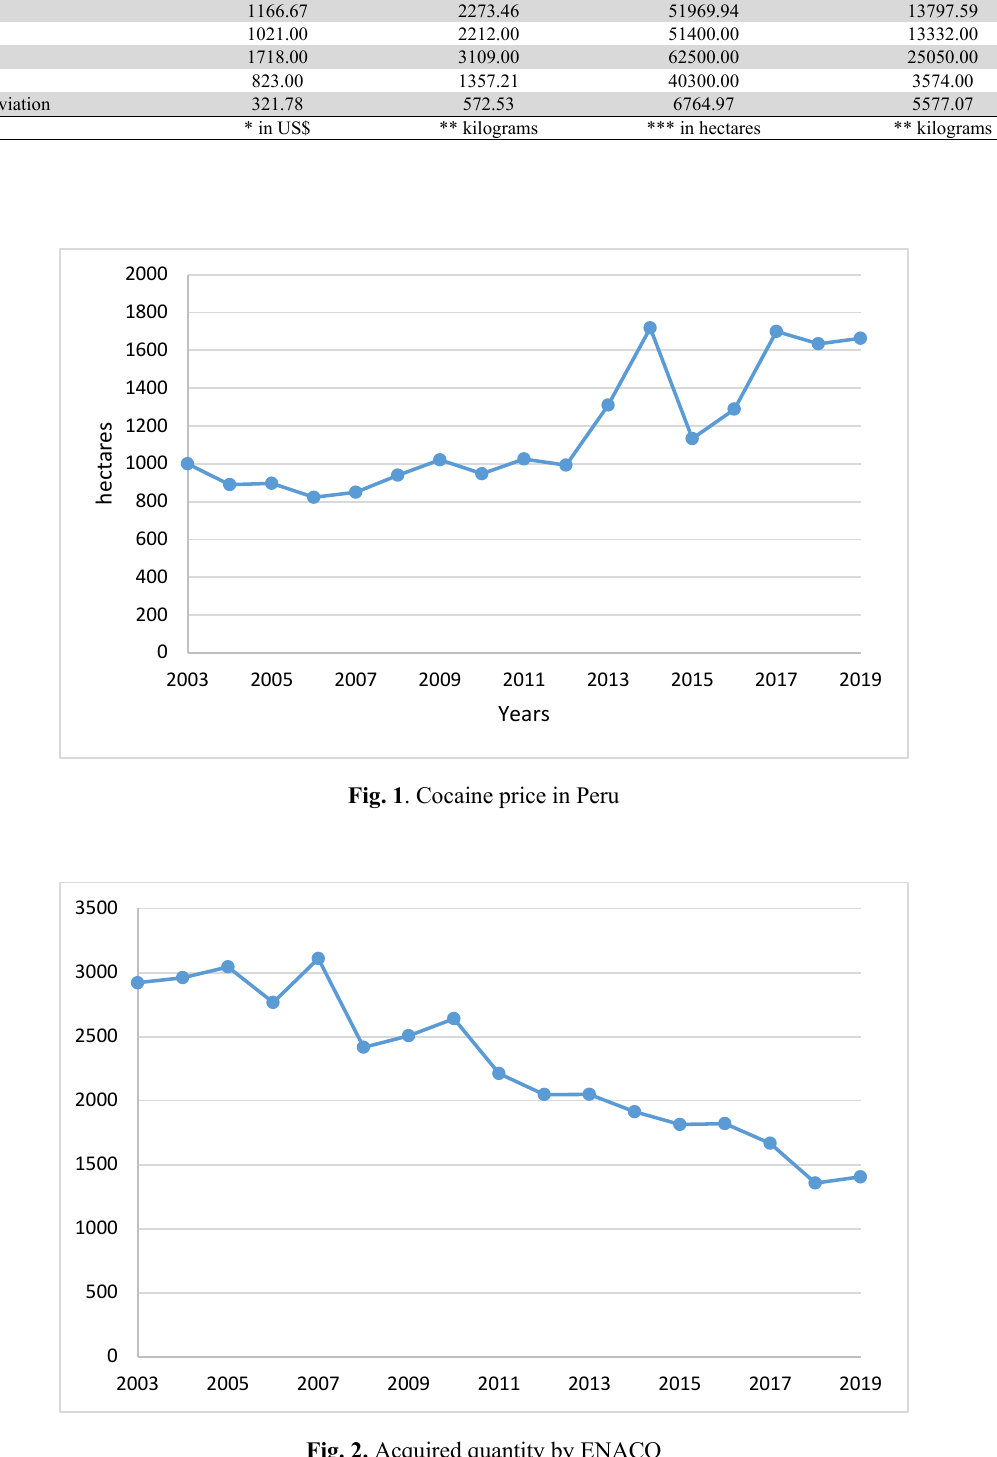
Fig. 2. Acquired quantity by ENACO